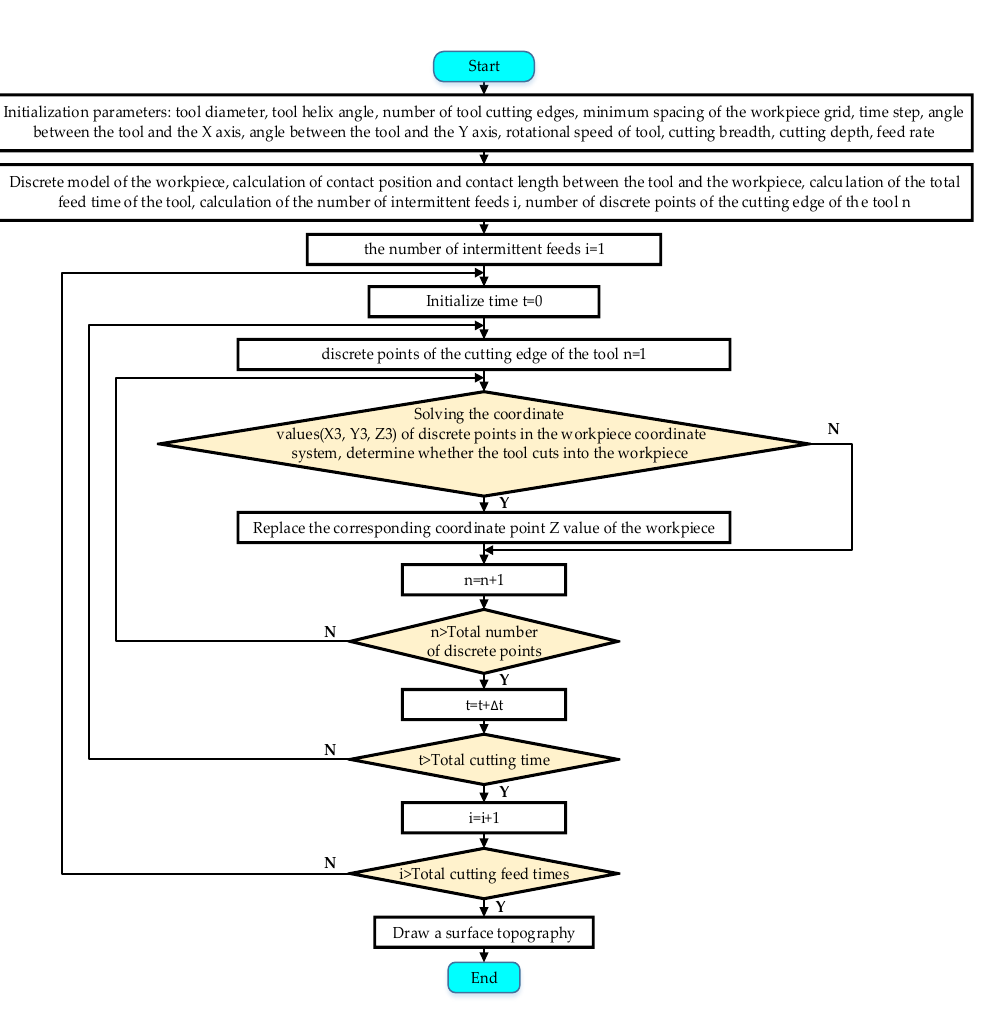
Figure 7. Flow chart of surface topography simulation.